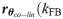
Relative co-linearity and co-circularity of the V1 interaction map w.r.t. to feedback.(A) In the end-zone. (B) In the side-zone. For each plot, the left and right block of bars represents the relative co-linearity (i.e. rθco-lin(kFB)) and co-circularity (i.e. rθco-cir(kFB)) with a feedback strength ranging from 1 to 4 w.r.t. their respective value without feedback (see Eqs 23 and 24). Bars’ heights represent the median over all the orientations, and error bars are computed as the median absolute deviation. The baseline represents co-linearity / co-circularity when kFB = 0.